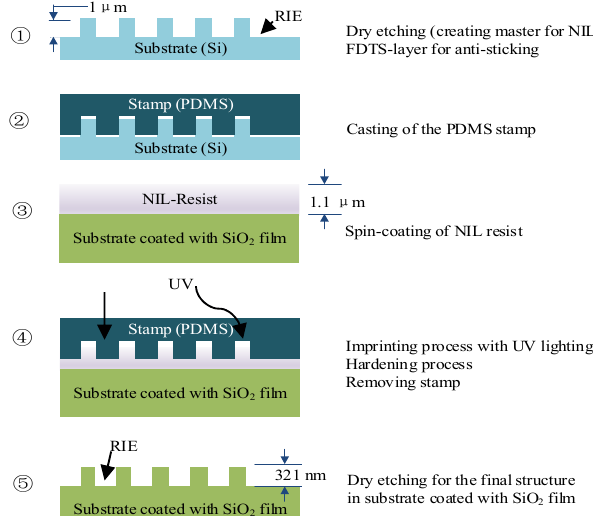
Figure 4. Process flow for the fabrication of the 2D grating.